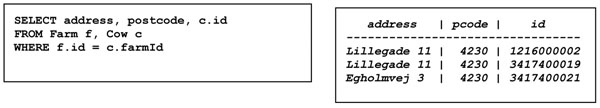
Query to list farms with associated cows